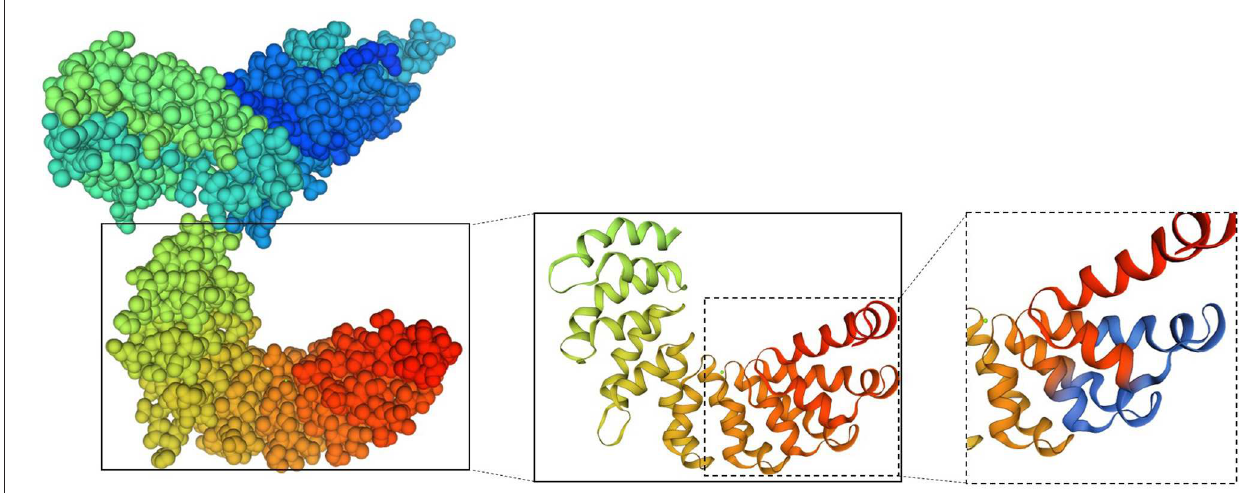
FIGURE 8 | Model of the 3D structure of the Sao-M protein predicted by SWISS-MODEL. The overall structure is shown on the left; the two core epitopes (aa SEKQMPSVVNENAVTPEK) at different positions are marked on the right in